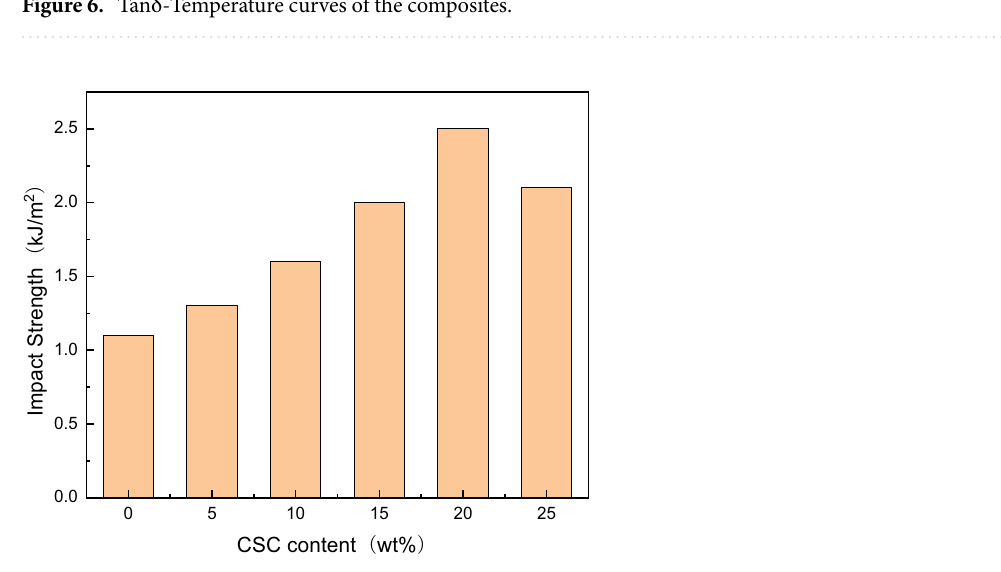
Figure 7. Impact strength drawing of the